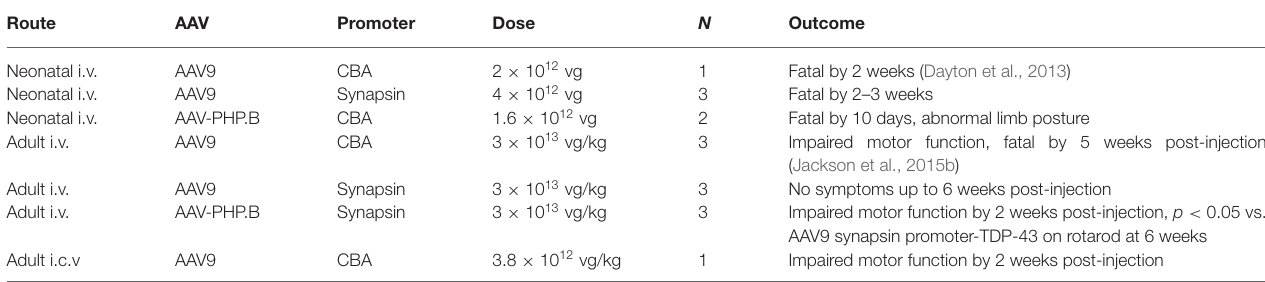
TABLE 1 | Outcomes of transactive response DNA-binding protein, 43 kDa (TDP-43)-induced phenotypes in small groups of rats. Route AAV Promoter Dose N Outcome Neonatal i.v. AAV9 CBA 2 × 10 12 vg 1 Fatal by 2 weeks (Dayton et al., 2013) Neonatal i.v. AAV9 Synapsin 4 × 10 12 vg 3 Fatal by 2–3 weeks Neonatal i.v. AAV-PHP.B 2 Fatal by 10 days, abnormal limb posture Adult i.v. CBA 3 × 10 13 vg/kg 3 Impaired motor function, fatal by 5 weeks post-injection (Jackson et al., 2015b) Adult i.v. AAV9 Synapsin 3 × 10 13 vg/kg 3 No symptoms up to 6 weeks post-injection Adult